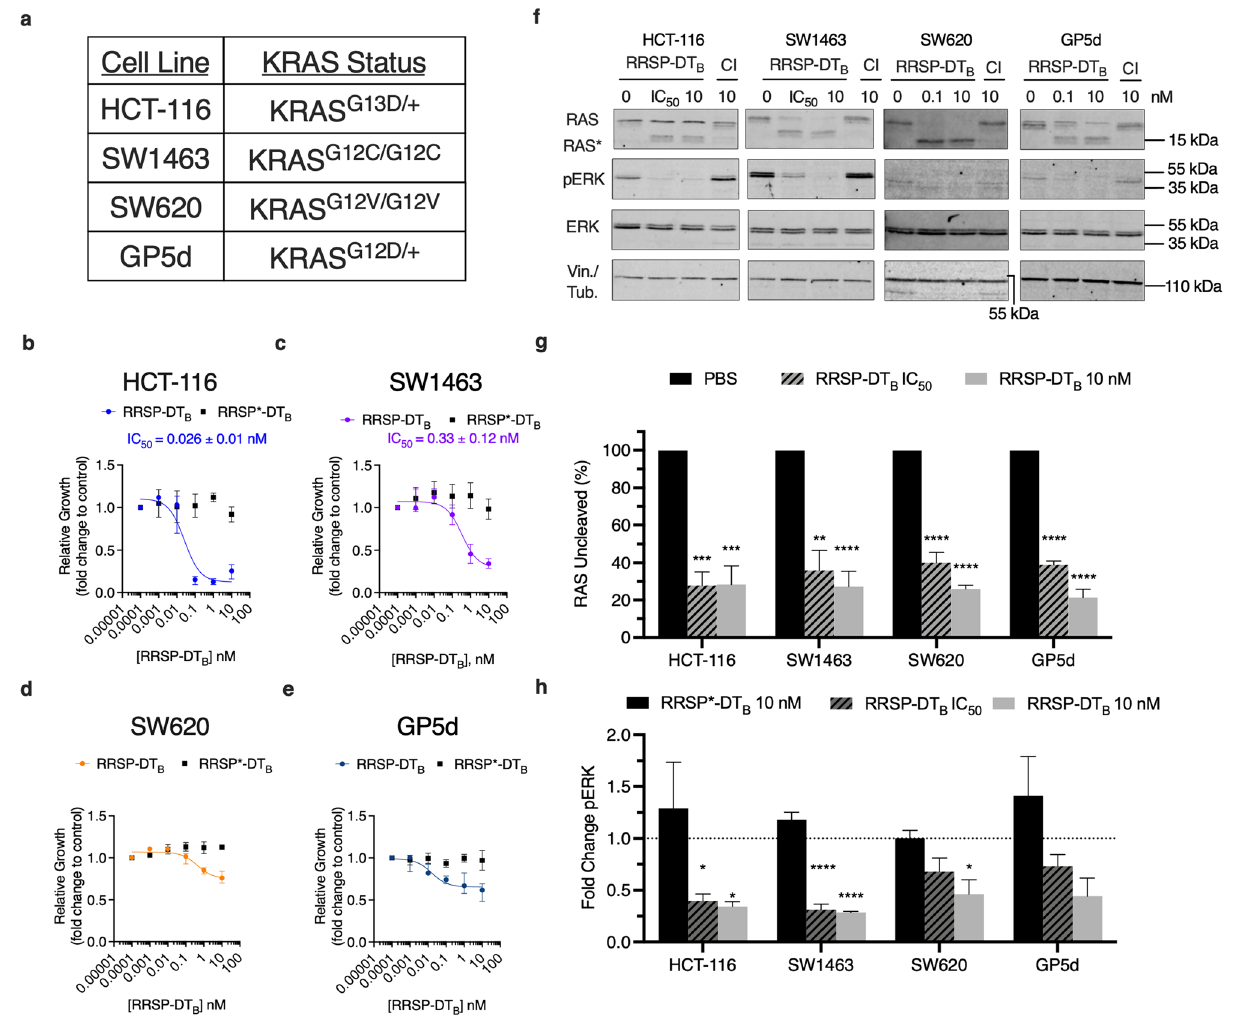
Figure 2. RRSP-DT B growth inhibition in CRC cell lines. ( A ) Cell line panel of KRAS mutant CRC cells used in this study. ( B–E ) Cell growth over time was monitored by time lapse video microscopy and cell confluency was quantified using ImageJ. Fitted dose response curve of RRSP-DT B in CRC cell lines show relative growth compared to PBS control after 24 h. Results are displayed as mean ± SEM, n = 4. ( F ) Representative western blot analysis of RAS cleavage and ERK inhibition in CRC cell lines treated with either RRSP-DT B or catalytically inactive mutant (labeled by CI) after 24 h. All concentrations are expressed in nanomolar. In all cell lines, vinculin was used as gel loading control except SW620 cells in which αTubulin was used. Protein detection for each immunoblot was conducted on the same blot and cropped for each individual protein of interest. Full length blots can be found in Supplementary Fig. 8. ( G,H ) Densitometric analysis of fold change in percent total RAS and pERK compared to PBS control after 24 h in CRC cell lines; n = 3. IC 50 concentrations for HCT- 116 and SW1463 can be found in Figs. 2B and 2C. For cell lines where IC 50 values could not be extrapolated (SW620 and GP5d) RRSP-DT B was used at 0.1 nM. Results are expressed as means ± SEM of three independent experiments (* P < 0.05, ** P < 0.01, **** P < 0.0001 versus PBS control as determined through one-way ANOVA followed by Dunnett’s multiple comparison